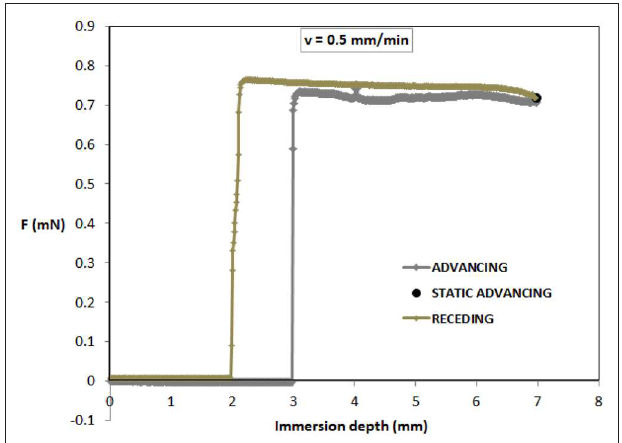
FIGURE 3 | Forced dynamic wetting curve for PEG1450 on cellulosic film at v = 0.5 mm/min.